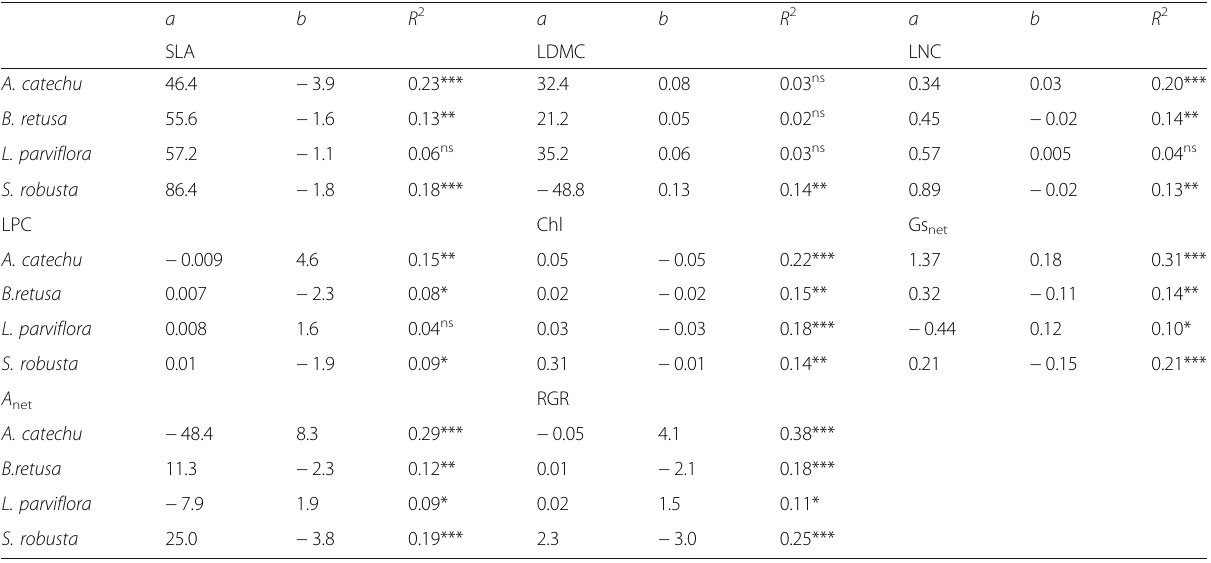
Table 6 Parameters of regression equations ( y = a + bx ) relating functional attributes ( y ) of four tree species with LT a ( x ) a b R